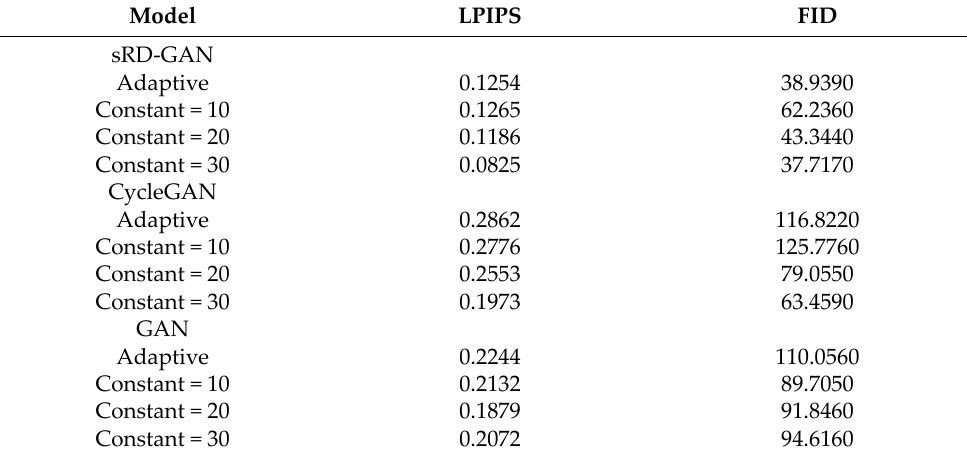
Table 2. Performance of GAN models with different pixel consistency loss settings.